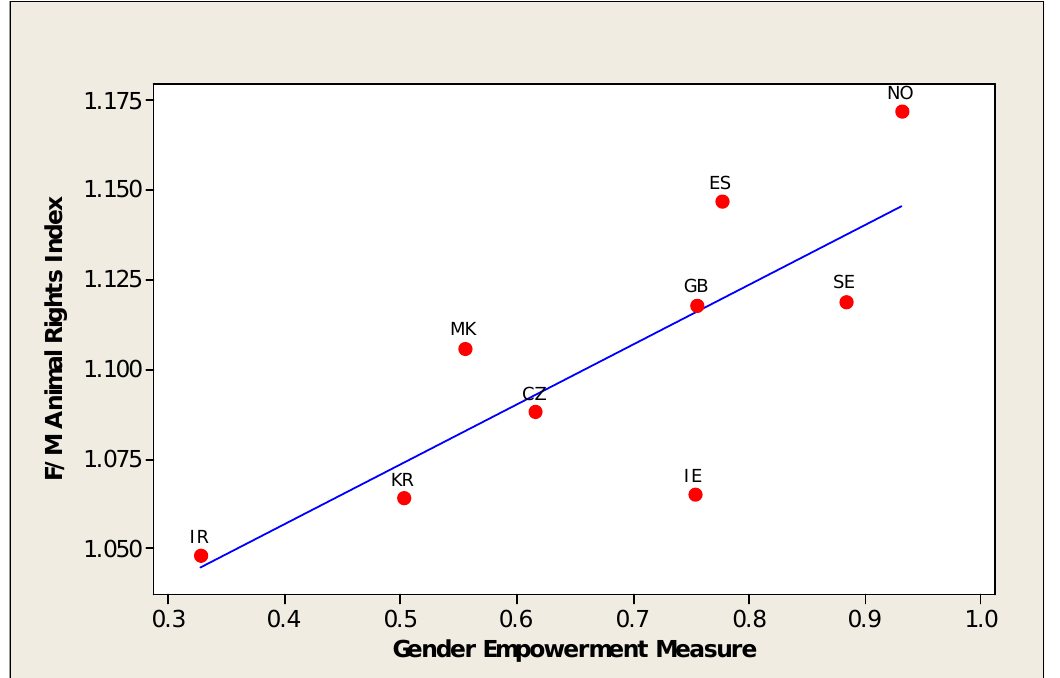
Figure 2. Ratio of female to male (F/M) scores on the Animal Rights Index to the Gender Empowerment Measure (GEM). CZ = Czech Republic, GB = Great Britain, IR = Iran, IE = Ireland, KR = South Korea, MK = Macedonia, NO = Norway, ES = Spain, SE =